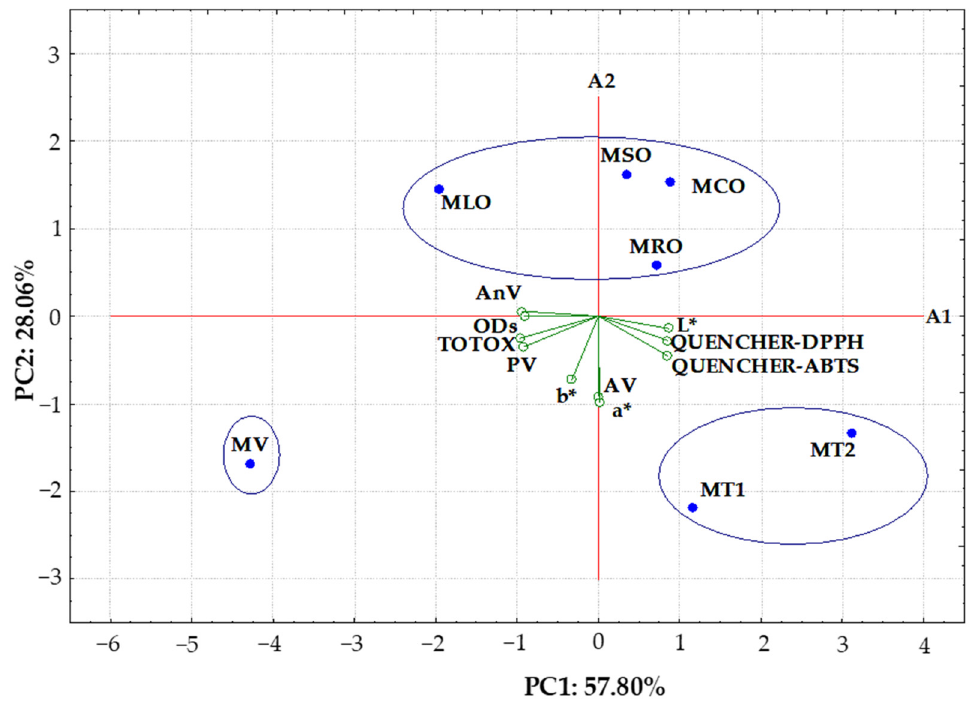
Figure 4. Biplot of scores and loadings of data obtained from radical scavenging properties (QUENCHER-DPPH, QUENCHER-ABTS), oxidation stability (PV—peroxide value; AnV—anisidine value; TOTOX—total oxidation index; AV—acid value), areas of oil droplets (ODs) and color parameters (L*—lightness; a*—redness; b*—yellowness) of aquafaba-based mayonnaise samples with blends of refined rapeseed oil and cold-pressed rapeseed oil (MRO), cold-pressed sunflower oil (MSO), cold-pressed linseed oil (MLO), and cold-pressed camelina oil (MCO); MT1—